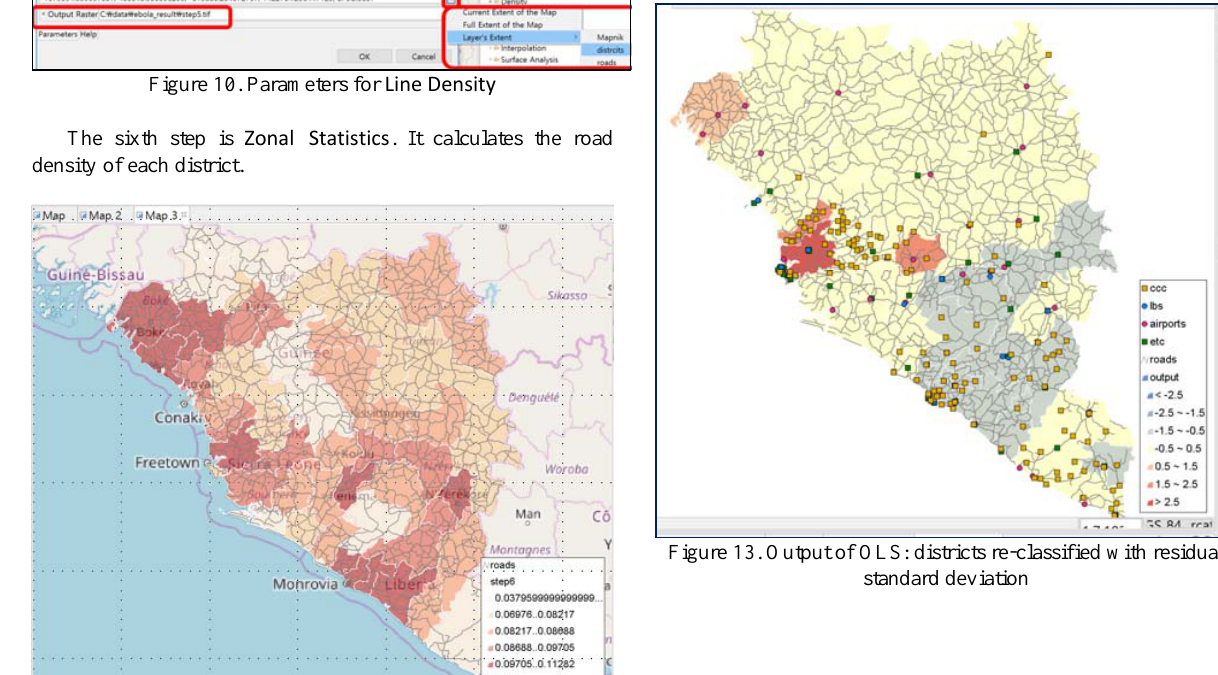
Figure 12. Parameters for OLS